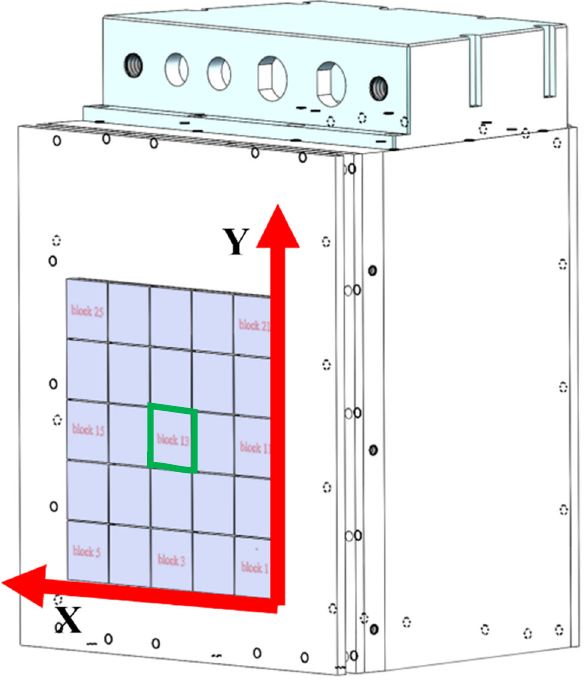
Fig. 7 Diagram of the block ID definition. The green frame refers to block